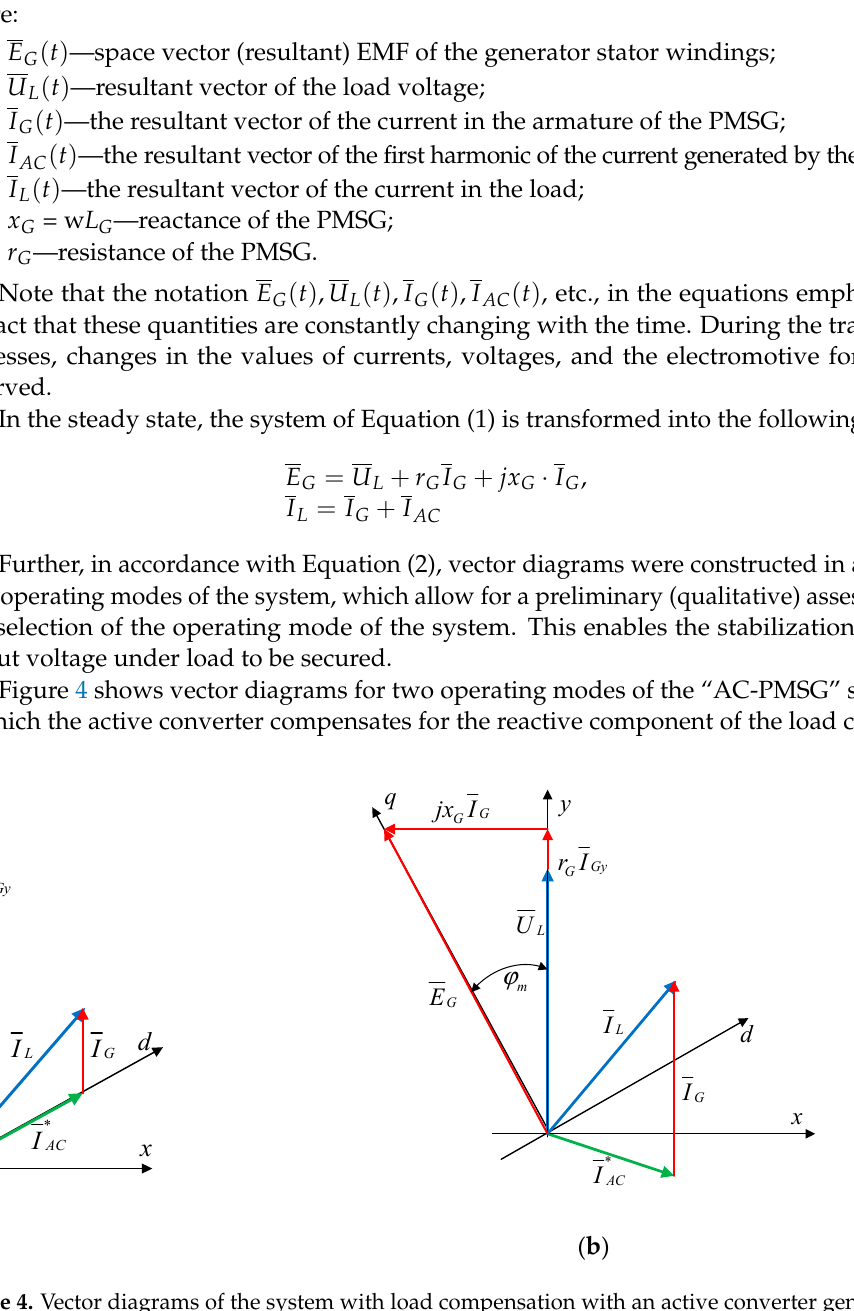
Figure 4. Vector diagrams of the system with load compensation with an active converter generating active and reactive currents (active and reactive powers): ( a ) The load current is the sum of the generator current and the current of AC. ( b ) the PMSG current feeds the load and charges the battery in the DC circuit. (red vectors—refer to PMSG, blue vectors—refer to load, green vectors—refer to